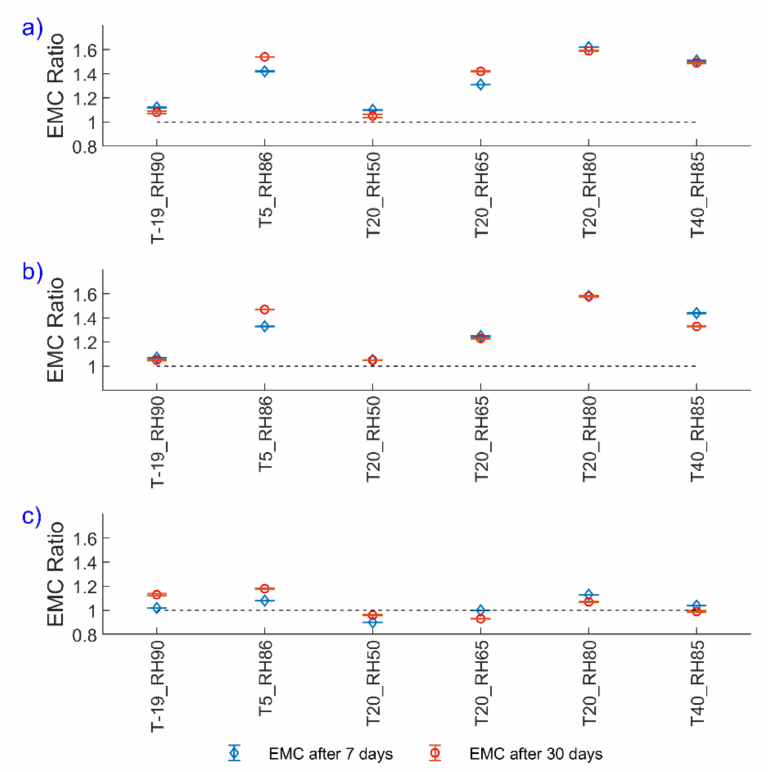
Figure 2. Equilibrium moisture content (EMC) ratio of pellets after 7 and 30 days of storage for ( a ) brown, ( b ) white, and ( c ) torrefied pellets. The error bars show the standard deviation and the dashed lines show the EMC for as-received